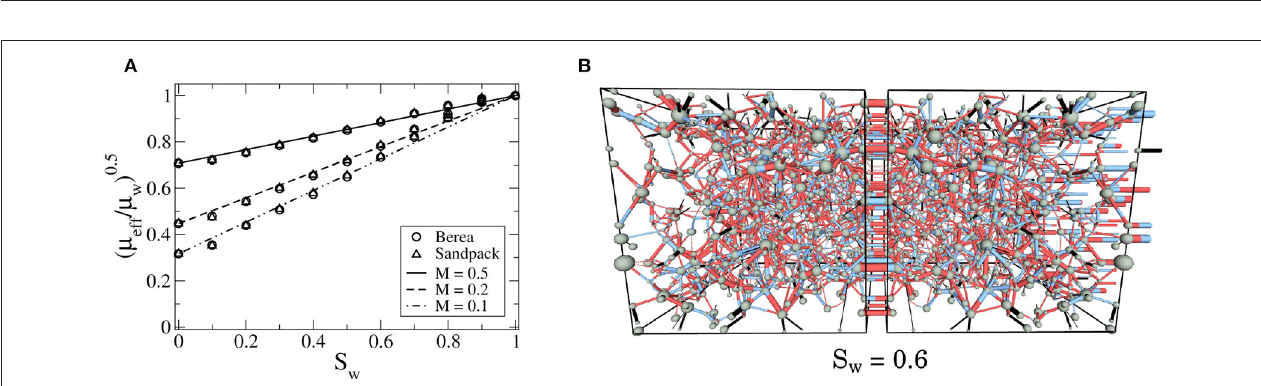
FIGURE 4 | (A) Plot of ( µ eff /µ w ) α obtained from network simulations with larger bubbles (B) or few interfaces (D) which shows α steady-state snapshot for model D, showing less mixing of fluids and larger clusters compared to Figure 1B .